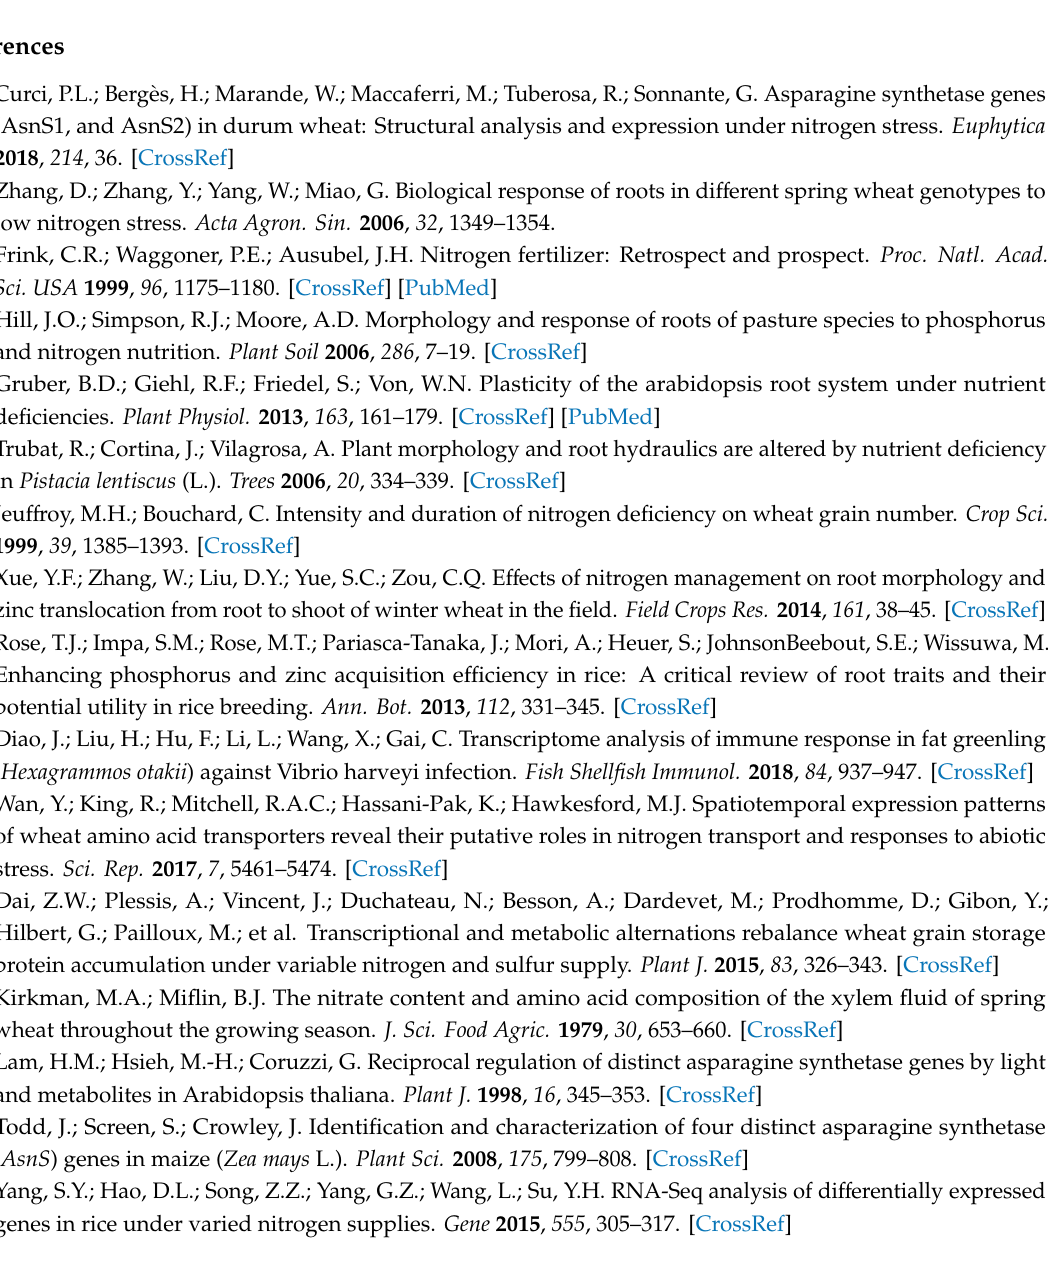
Figure S1: View of wheat seedlings growth in CK and N- groups. Table S1: All expression datasets of DEGs under low N stress in roots. Table S2: All expression datasets of DEGs under low N stress in leaves. Table S3: GO enrichment analysis for DEGs in wheat seedlings under low nitrogen stress (leaf). Table S4: GO enrichment Table S6: Primer information for